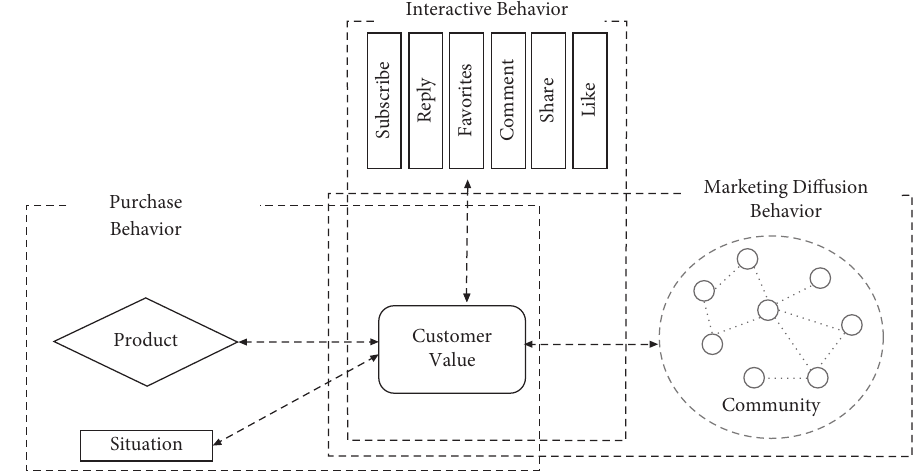
Figure 1: The source of customer value in the mobile Internet